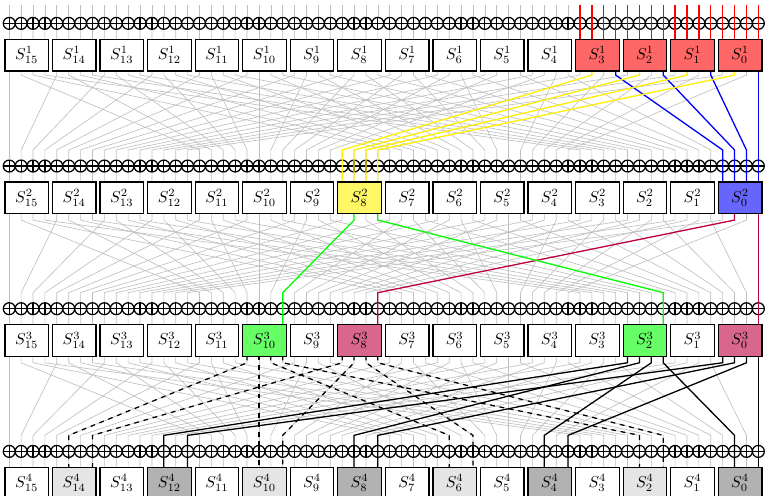
Figure 6: PRESENT differential patterns. Input differences are in red and the round 1 convergence goes to either the blue or yellow pattern. The round 2 convergence then goes to exactly one of the purple (if comes from blue path) or green (if comes from yellow path)